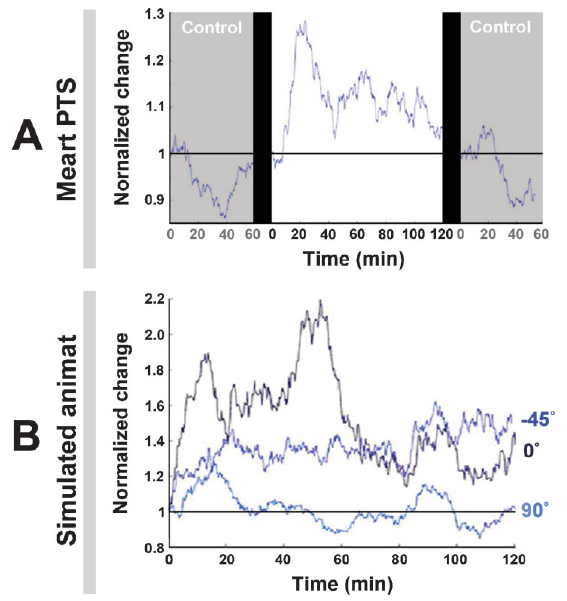
Figure 8. Neuronal plasticity . A . An experiment with MEART (data is the same as Figure 7 , left) run for 2hour and compared to 1hour probe- only periods before and after. “Normalized change” is a comparison of the movement outputs (the CAs) in any 10minute period to those of the first 10minutes. At time = 0, the same periods were compared, giving no change (a value of 1), and the 10-minute window for subsequent values was stepped by 1minute. The drop below 1 in the control periods meant the variability in CAs decreased, possibly indicating a habituation to the stimulation. The addition of training stimuli caused plasticity, but not behavioral success ( Figure 7 ). B . The experiments with the animat (data is the same as Figure 7 , right) run for 2hours. The adaptive training algorithm caused plasticity. For 90 degrees, change hovered around 1 because this was the direction of bias, a 60 degree/360 degree chance.